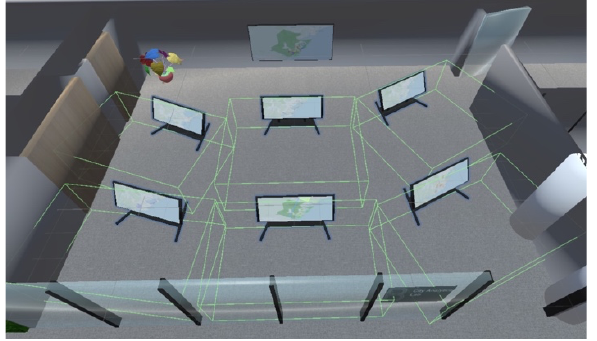
Figure 3: Virtual room for urban planning support